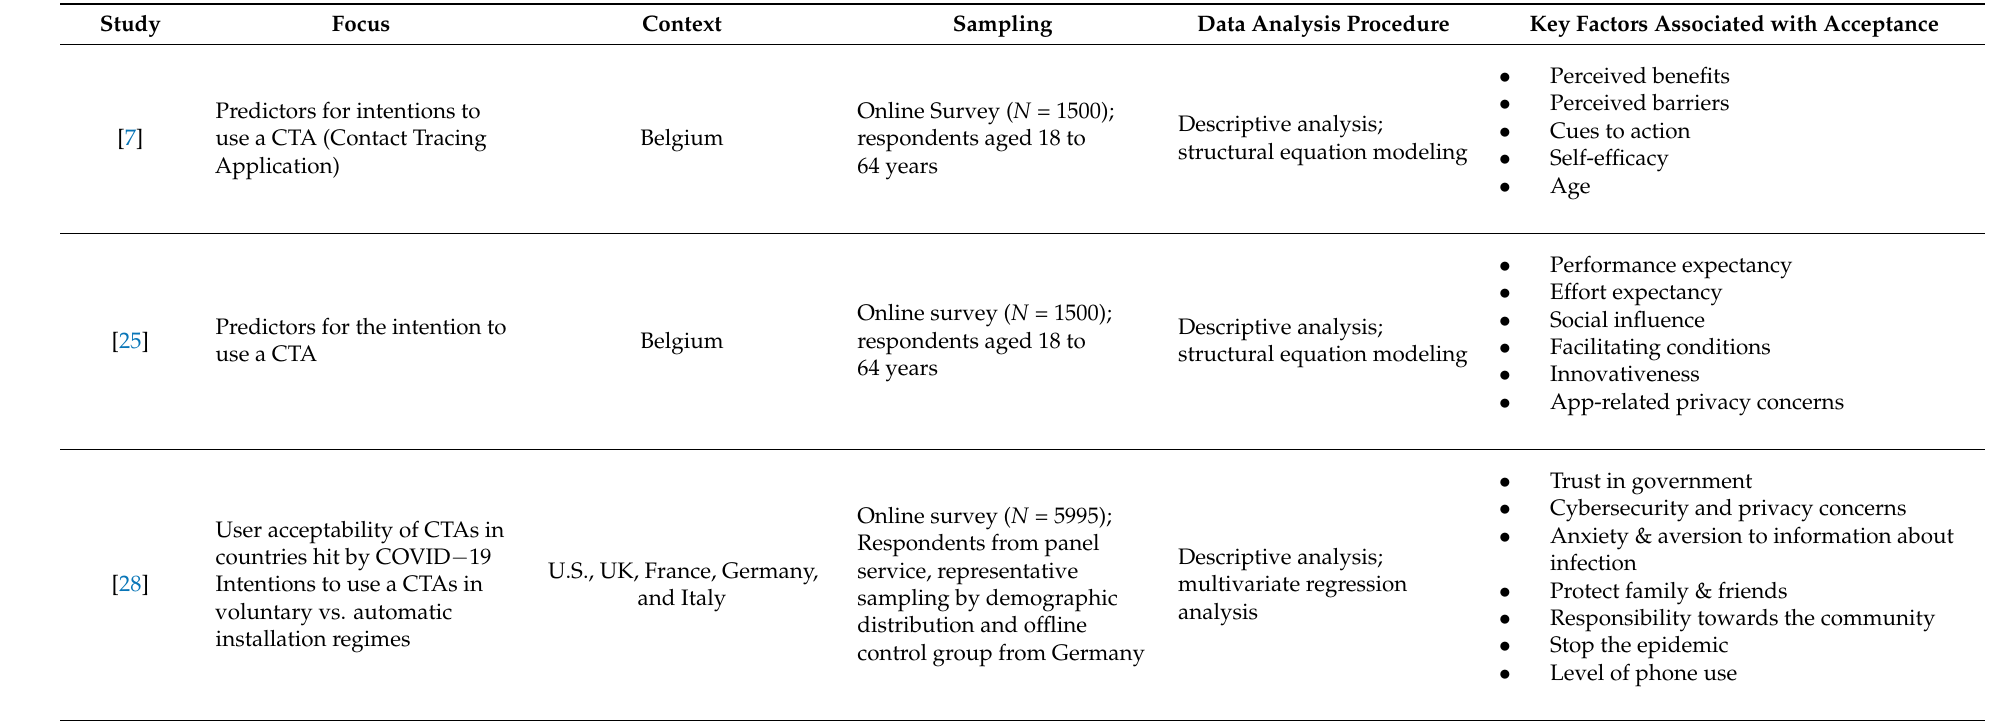
Table A1. List of all the empirical studies ( N = 25) included in the present scoping